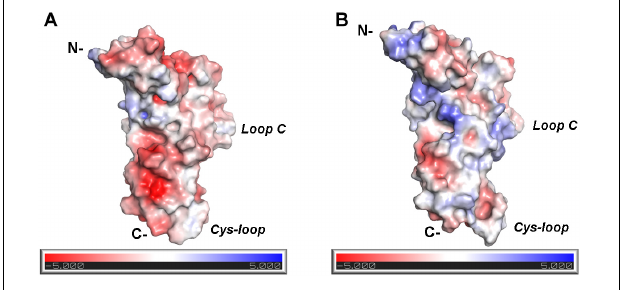
FIGURE 6 | Electrostatic potential distribution at the (–) sides of α 9 and α 10 nAChR-ECDs. (A) α 9-ECD. (B) α